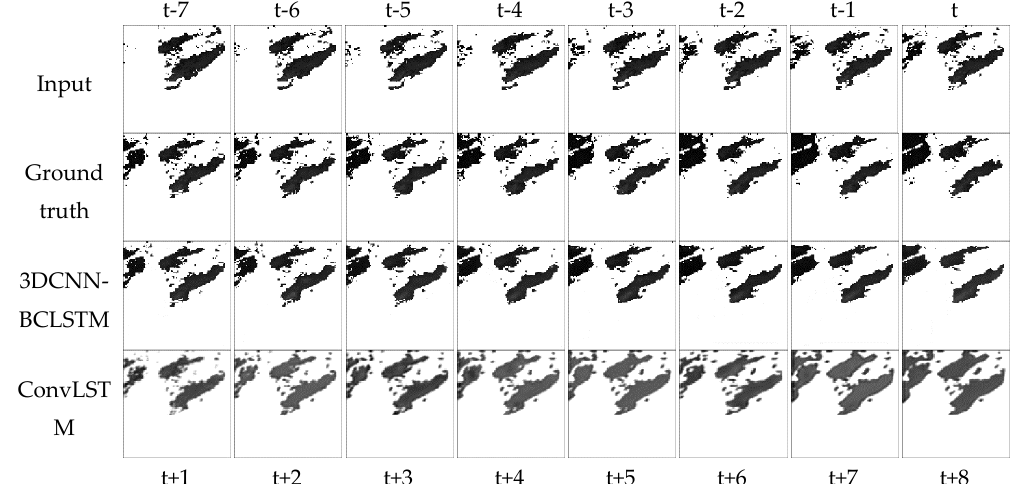
Figure 8. The same that Figure 7, but for the case of formation for radar echo nowcasting at 21:18 UTC on 10 August 2016. From top to bottom: input, ground truth, prediction of 3DCNN-BCLSTM model, prediction of ConvLSTM